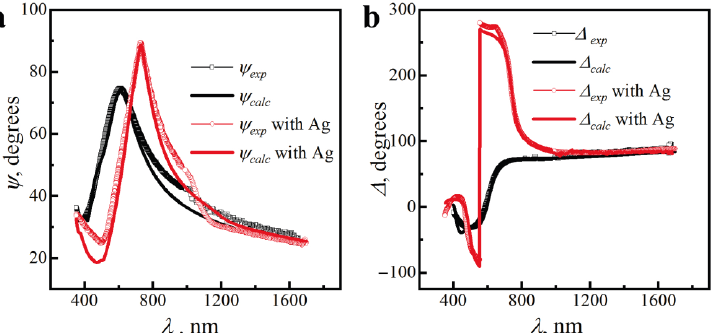
Figure 5. Experimental ( exp ) and calculated ( calc ) ellipsometric spectra ( a ) ψ ( λ ) and ( b ) Δ ( λ ) of SiNWs before (black) and after (red) AgNPs deposition for sample S1.